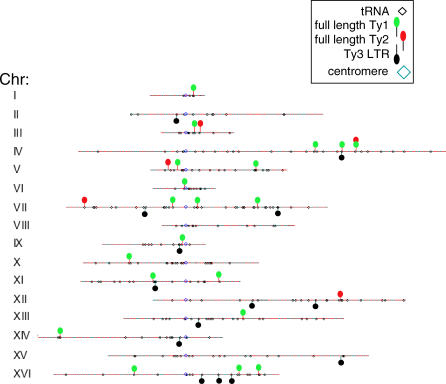
Transposon Map of SK1The positions of Ty1 and Ty2 full-length elements and Ty3 LTR elements in strain SK1 are shown, based on Agilent yeast whole genome microarray (Ty1 and Ty2) and Agilent ORF array (Ty3 LTR) analysis of this uncharacterized genome.